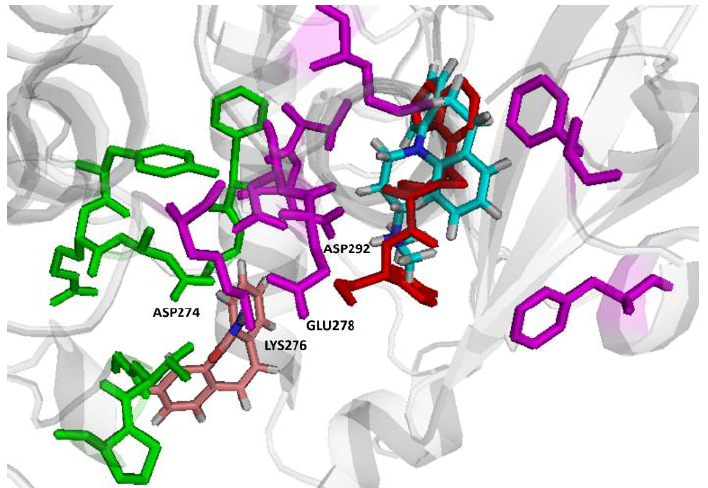
Figure 9. Comparative binding positions of co-bound CBZ (brown) bound to an allosteric pocket (residues shown in green) and IMI (light blue) with the reference crystallized ligand, AZD5363 (red) bound to Akt (PDB Code: 4GV1) active site (residues shown in magenta).